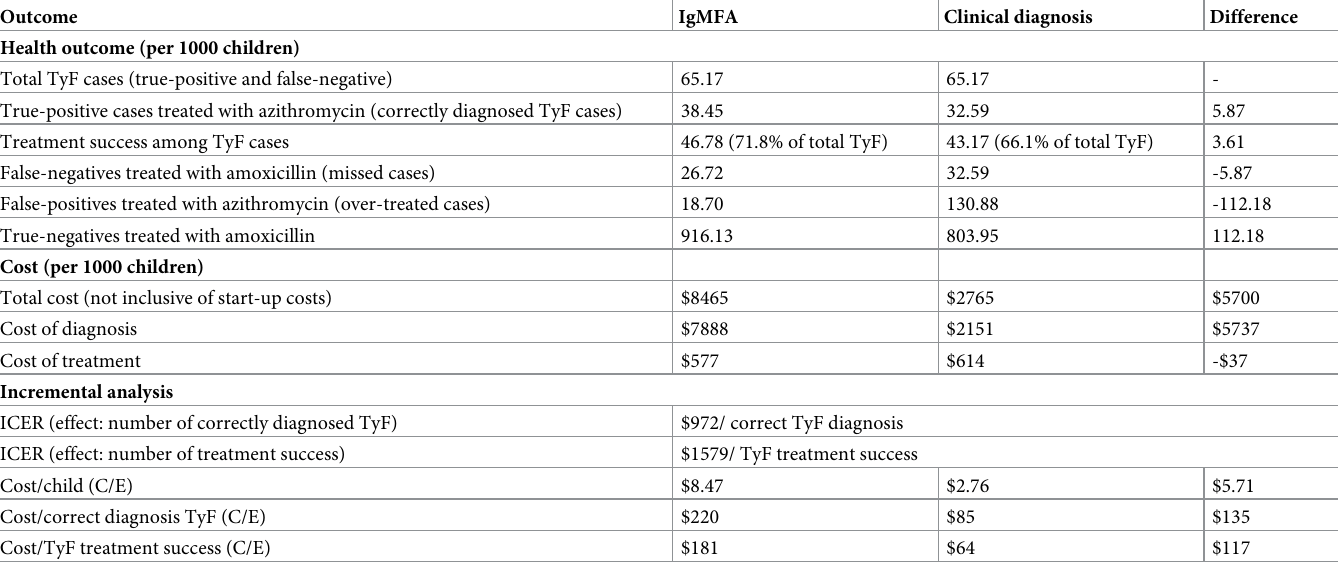
Table 4. Incremental health outcomes and